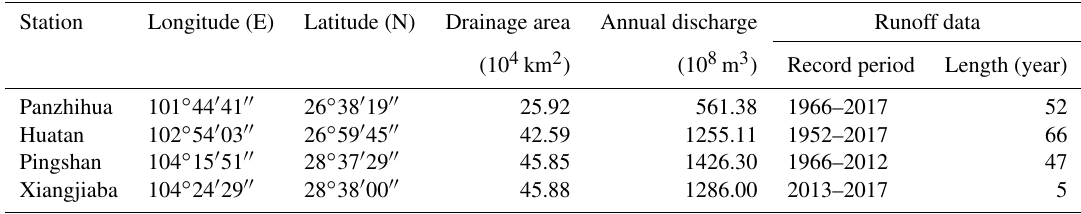
Table 2. List of hydrological stations and their